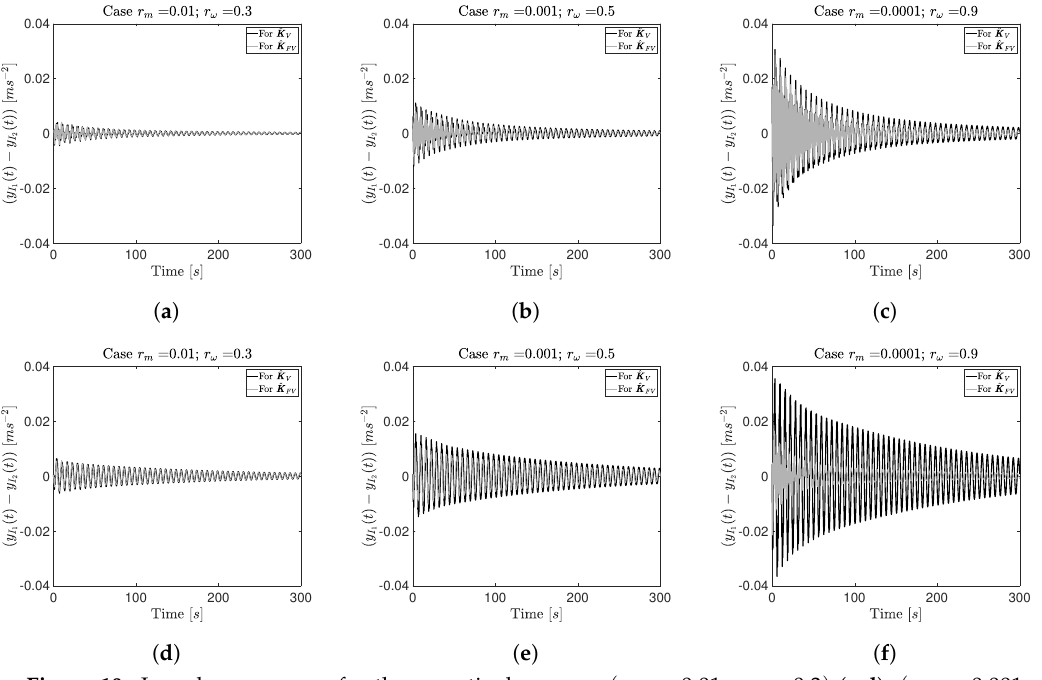
Figure 10. Impulse responses for three particular cases: ( r m = 0.01, r ω = 0.3 ) ( a , d ); ( r m = 0.001, r ω = 0.5 ) ( b , e ); and ( r m = 0.0001, r ω = 0.9 ) ( c , f ), for a single disturbance input ( top row ) and three disturbance inputs for the non-symmetrical case ( bottom row